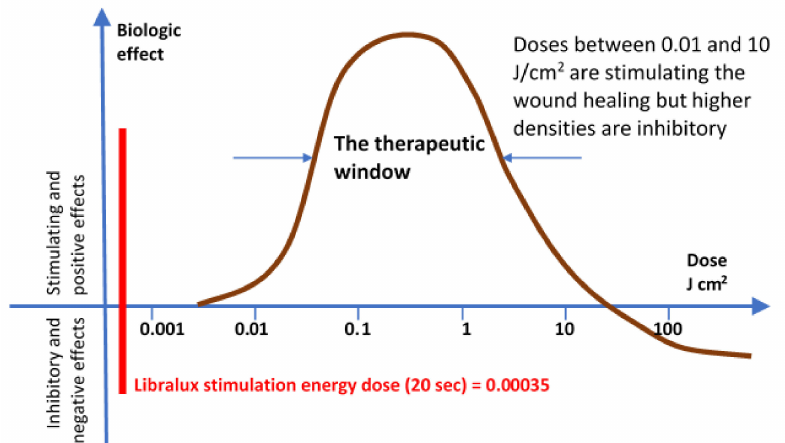
Figure 1. The Arndt and Schulz law for Lasertherapy (modified from